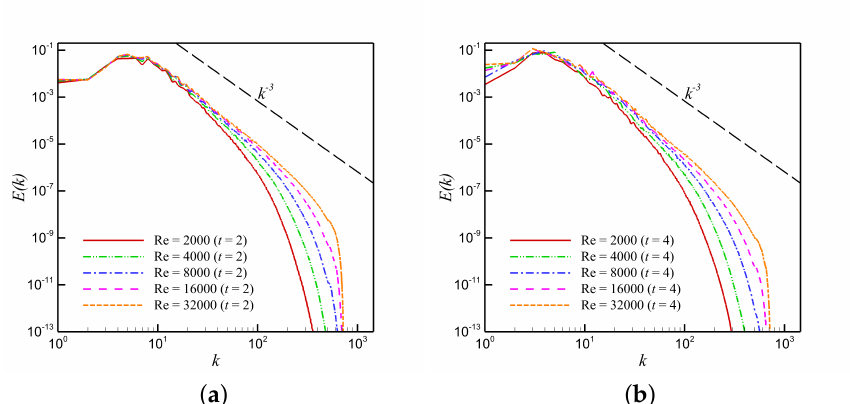
Figure 1. Evolution of energy spectra in 2D decaying Kraichnan turbulence for Re ∈ {2000, 4000, 8000, 16,000, 32,000 } at t = 2 ( a ) and t = 4 ( b ). Notice the convergence of energy spectrum in the inertial range to the k − 3 scaling with increasing Reynolds number.